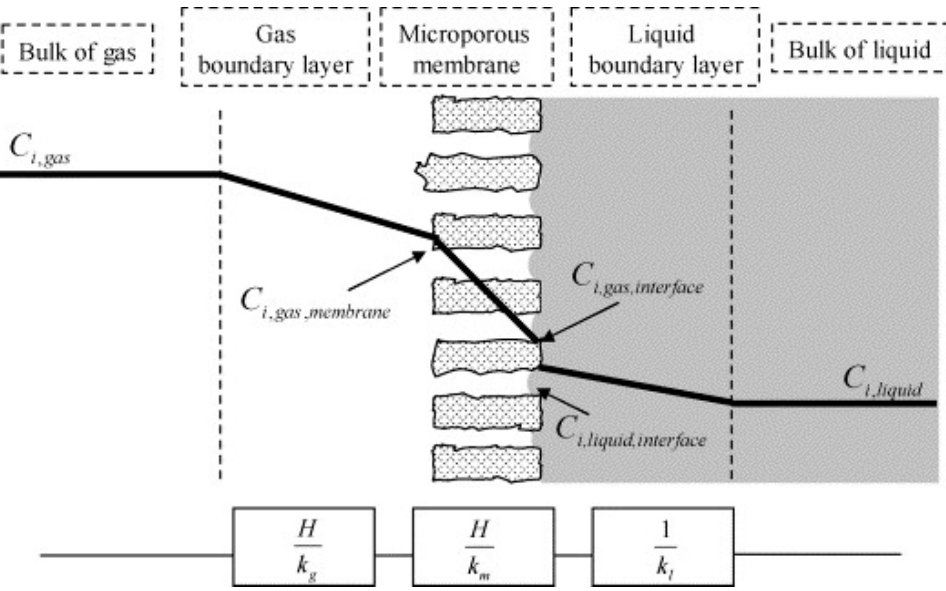
Figure 3. Mass transfer process of a gas-liquid contact membrane (Reprinted with permission from Ref. [33], 2022, Elsevier.)